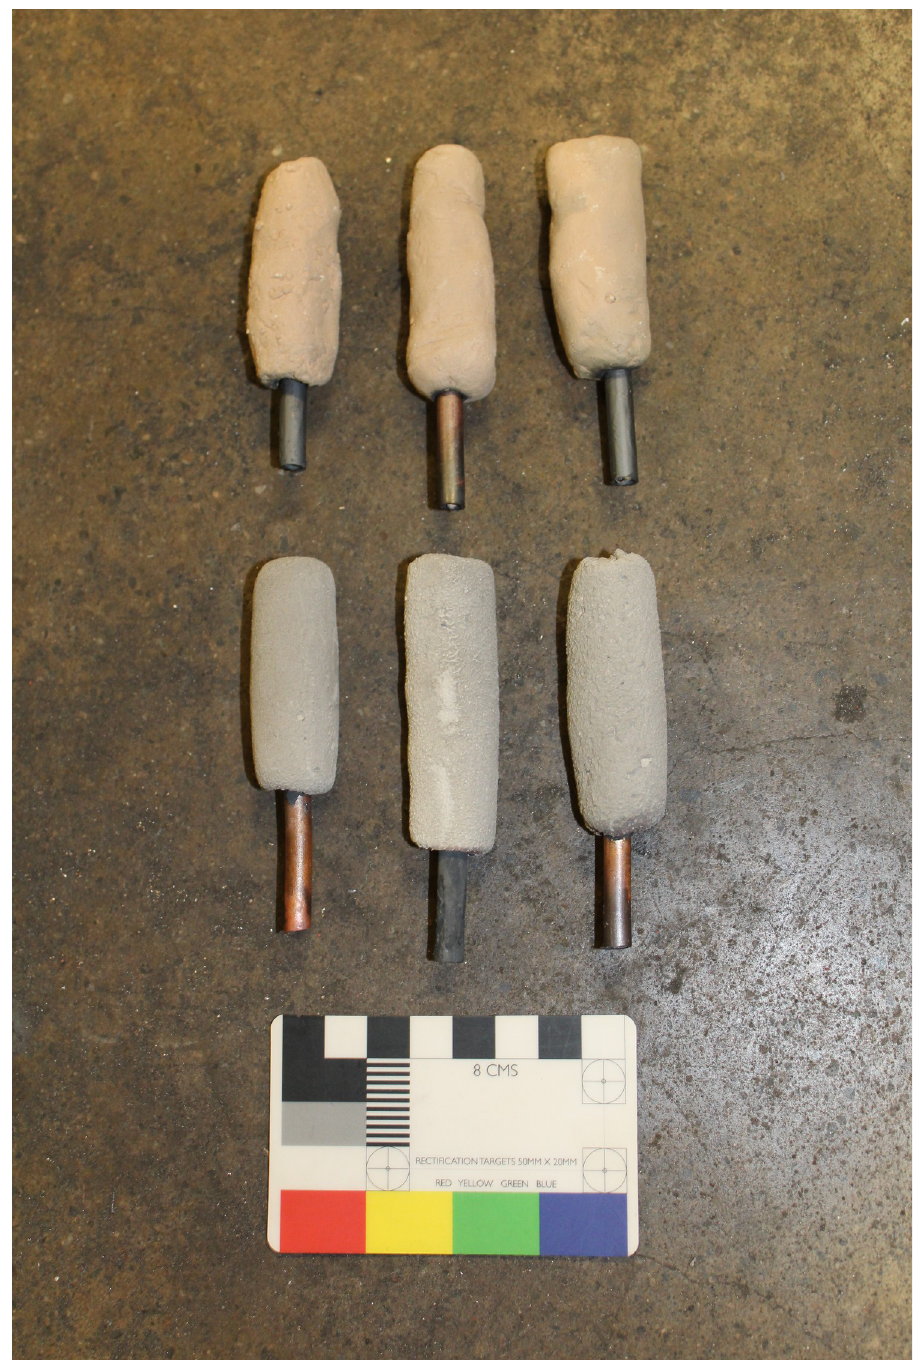
Fig 3. Experimental tuy è res. Experimental tuy è res made from modern commercial stoneware clay (top row), and local clay from the Mayapa´n region (bottom row). Photograph by Elizabeth Paris. thermocouple, to measure the temperature near the aperture of each tuy è re, and a hole for a fourth thermocouple was drilled approximately 2 cm below the rim of the crucible, to measure the internal temperature in the upper portion of the crucible (Fig 4). In the first experiment,